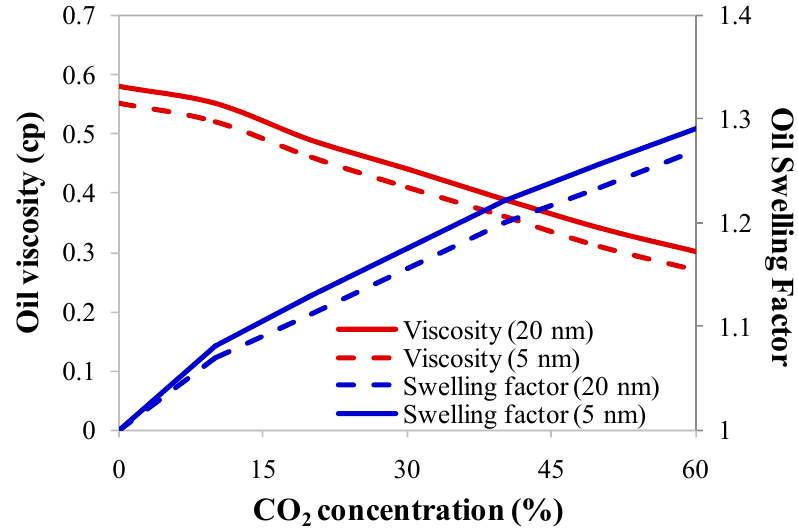
Figure 10. Oil viscosity and swelling factor under different CO 2 concentrations.